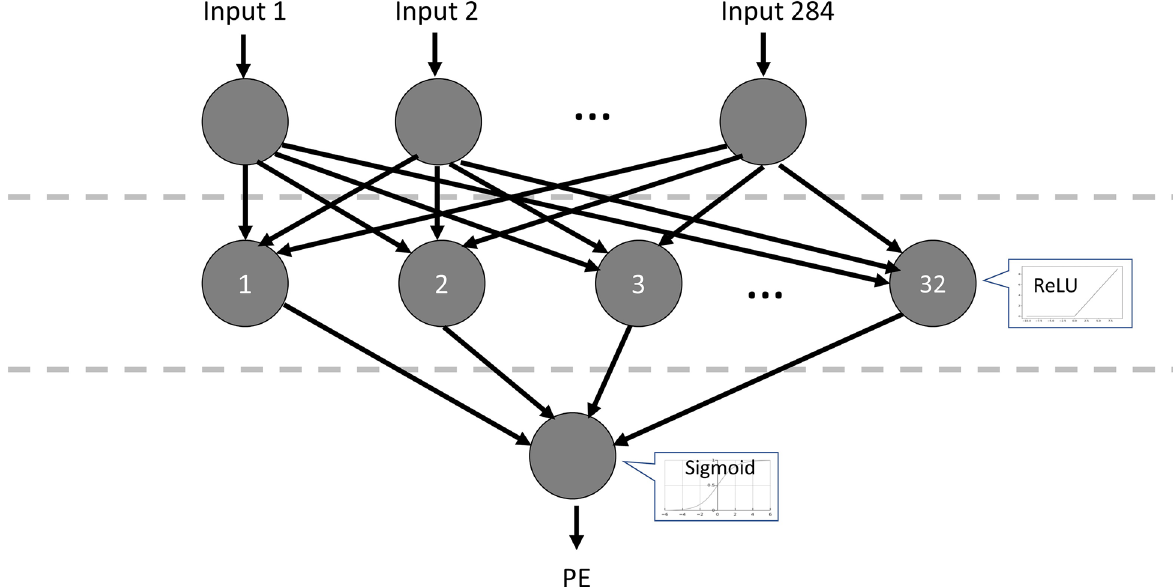
Fig. 6 Deep-learning model for the PE class with 284 inputs, 32 fully connected hidden nodes, and one